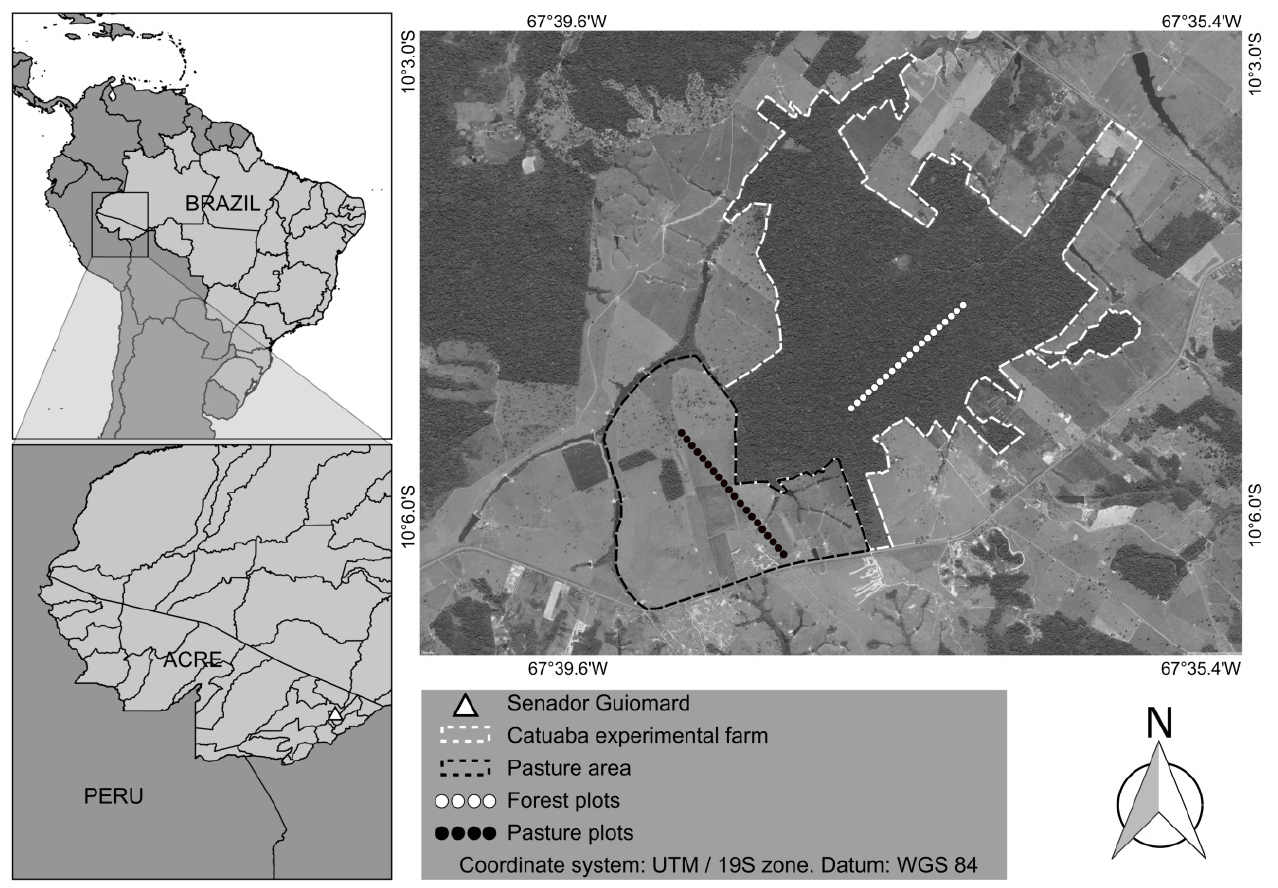
Fig 1 . Catuaba Experimental Farm - UFAC and São Francisco Farm, with 20 plots in each habitat type (forest and pasture), in the southwestern Brazilian